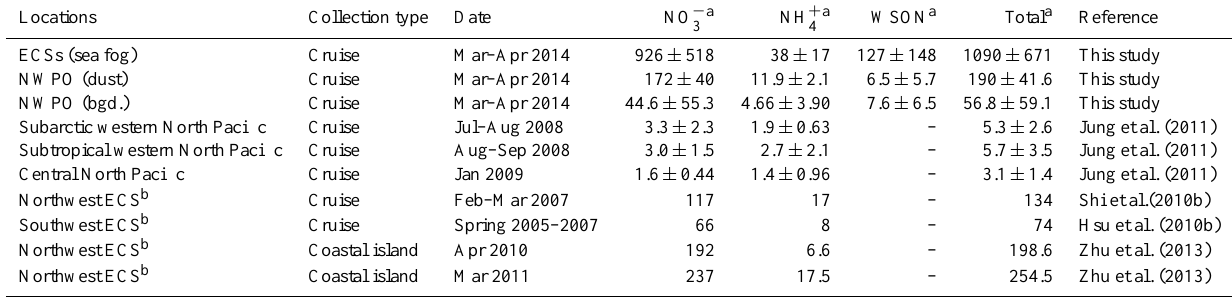
Table 3. The depositional fluxes reported or calculated for the Asian region and Pacific Ocean based on assumed deposition velocity.